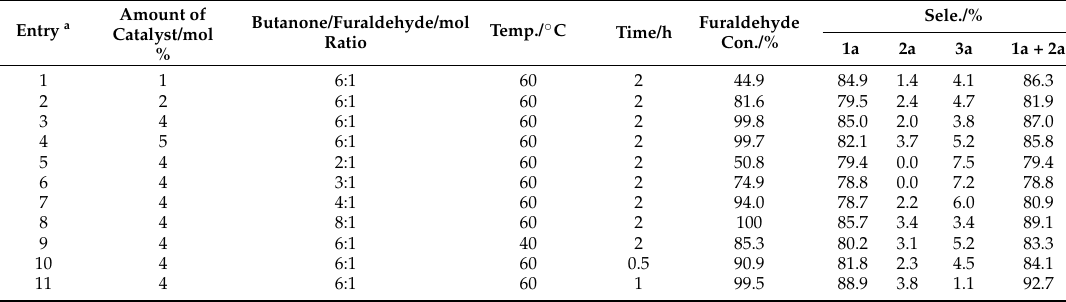
Table 2. Effect of different reaction conditions using 3-pyrrolidinamine as the